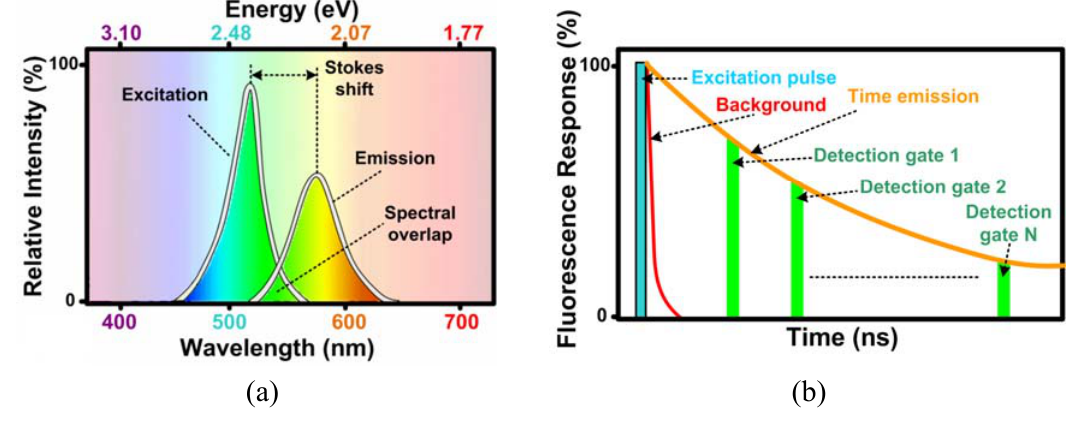
Figure 1. (a) Fluorescence spectral response showing the excitation pulse and the emission pulse . (b) Time-resolved and fluorescence lifetime measurements